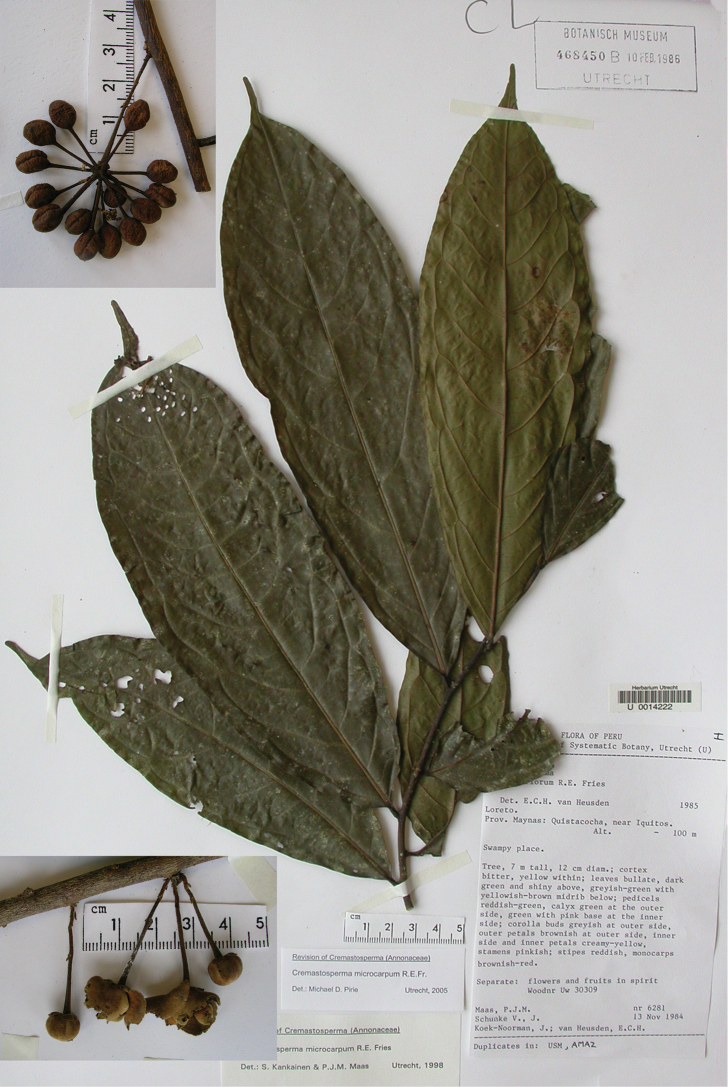
Cremastospermamicrocarpum R.E.Fr. a leaves b flowers and flower buds c fruit (a, bMaas et al. 6281cVásquez & Jaramillo 9350).